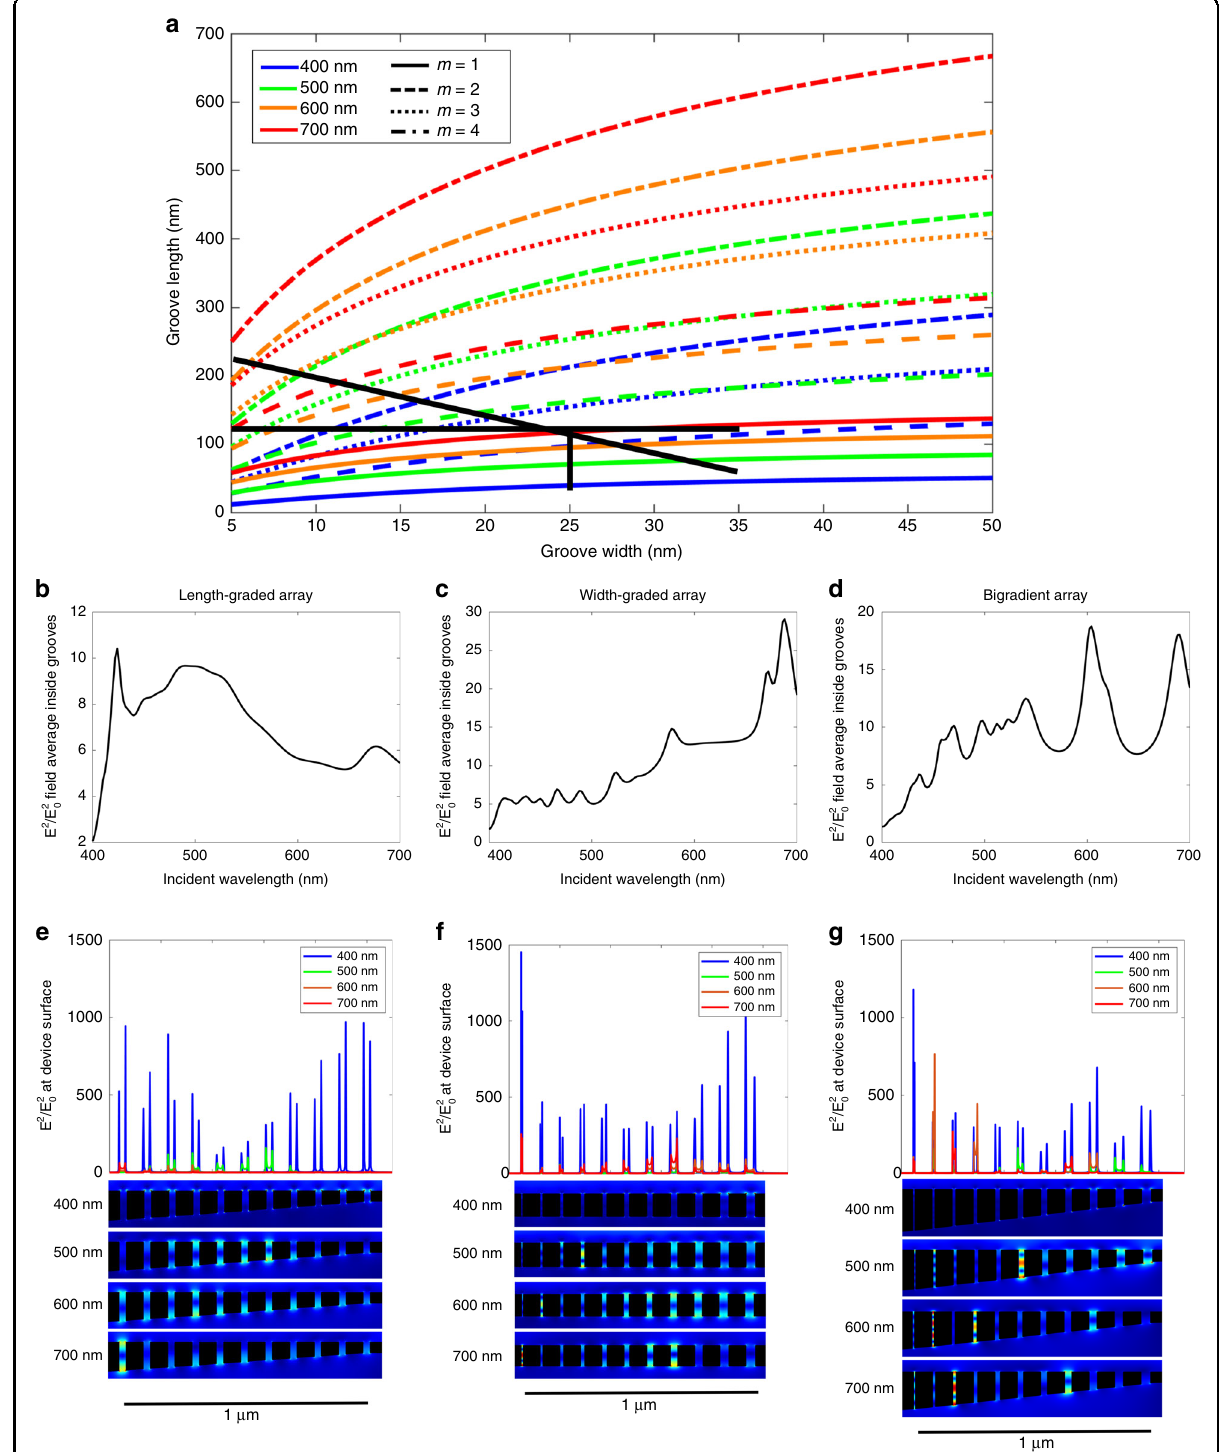
Fig. 3 Design of three array con fi gurations and resulting electromagnetic fi eld pro fi les. a Analytical calculation of the fi rst four resonant modes of an Ag-MgF 2 -Ag cavity in the visible regime. Black lines illustrate the groove geometries used in the three array designs. The vertical line represents the length-graded array, the horizontal line represents the width-graded array and the diagonal line represents the bigradient array. b – d COMSOL simulation of the average fi eld intensity inside the grooves across the entire visible spectrum for the length-graded, width-graded and bigradient designs, respectively. e – g COMSOL simulation of the electric fi eld intensity at the surface of the array for the length-graded, width-graded and bigradient designs, respectively, at select wavelengths in the visible regime, along with simulated two-dimensional fi eld intensity maps at the four